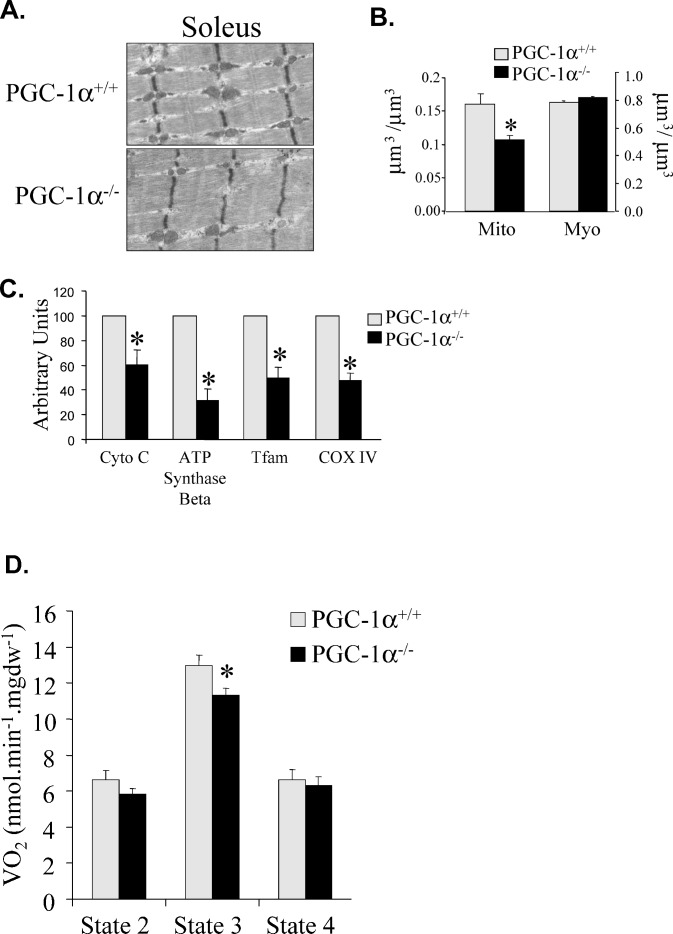
Abnormal Mitochondrial Phenotype in Slow-Twitch Skeletal Muscle of PGC-1α−/− Mice(A) Representative electron micrograph of soleus muscle from 1-mo-old female PGC-1α+/+ and PGC-1α−/− mice.(B) Quantitative morphometric measurements of the cellular volume density for the mitochondrial (Mito) and myofibrillar (Myo) fractions based on analysis of electron micrographs (three sections from three animals per group). The bars represent mean ± SEM. * p < 0.05 compared to corresponding PGC-1α+/+ values.(C) Gene expression data. The results of real-time PCR analysis of nuclear and mitochondrial genes involved in various components of mitochondrial metabolism and mitochondrial biogenesis: cytochrome C (Cyto c), ATP synthase β, Tfam, and cytochrome oxidase IV (COX IV). Eight littermate pairs were used for analysis at 1–2 mo of age and normalized to the WT value, which was assigned a value of 100, in each case. * p < 0.05 compared to corresponding PGC-1α+/+ values.(D) Mitochondrial respiration rates as determined by oxygen consumption (VO2) performed on saponin-permeabilized muscle strips prepared from soleus of PGC-1α+/+ and PGC-1α−/− mice (as described in Materials and Methods). The results are based on six female animals in each group, using succinate as a substrate in the presence of rotenone. Mean values (± SEM) are shown for state 2 (basal), state 3 (ADP-stimulated), and state 4 respiration (presence of oligomycin).